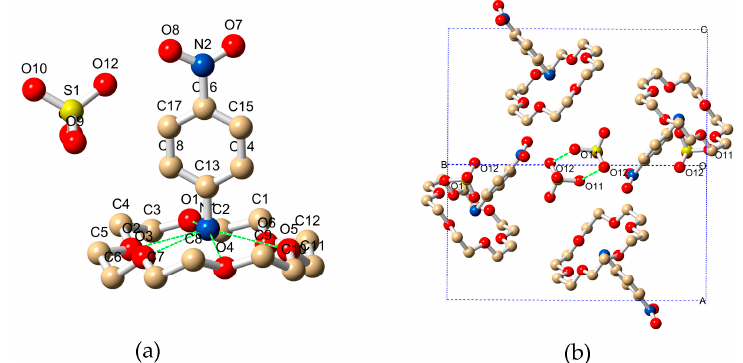
Figure 1. Crystal structure of crystal 1 at 100 K. ( a ) Asymmetric unit for crystal 1 , dashed lines indicate hydrogen bonds; ( b ) Unit cell of crystal 1 viewed along the a + c axis. Most hydrogen atoms on carbon atoms are omitted for clarity. Crystals 2017, 7, 224